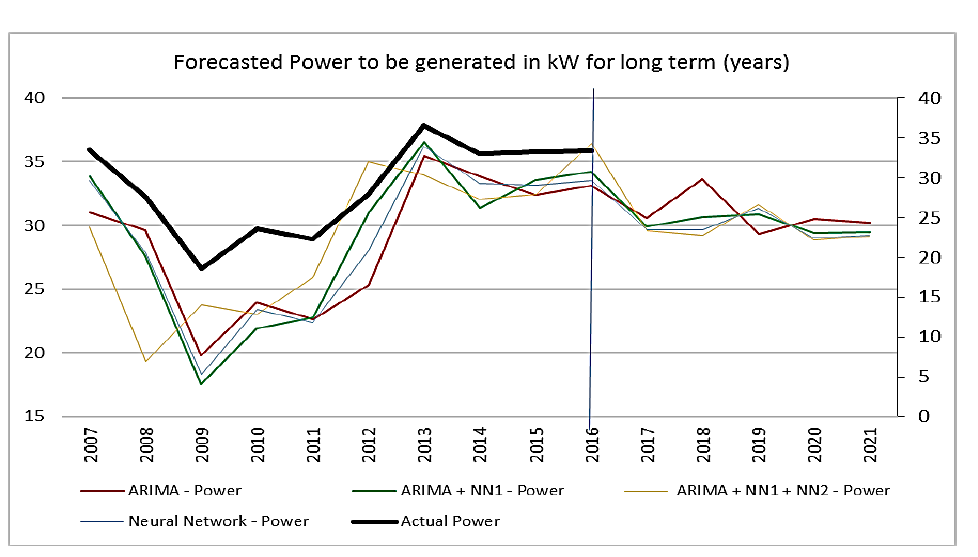
Figure 18. Estimated Speed in m/s for long-term forecast (years). Source: Authors.